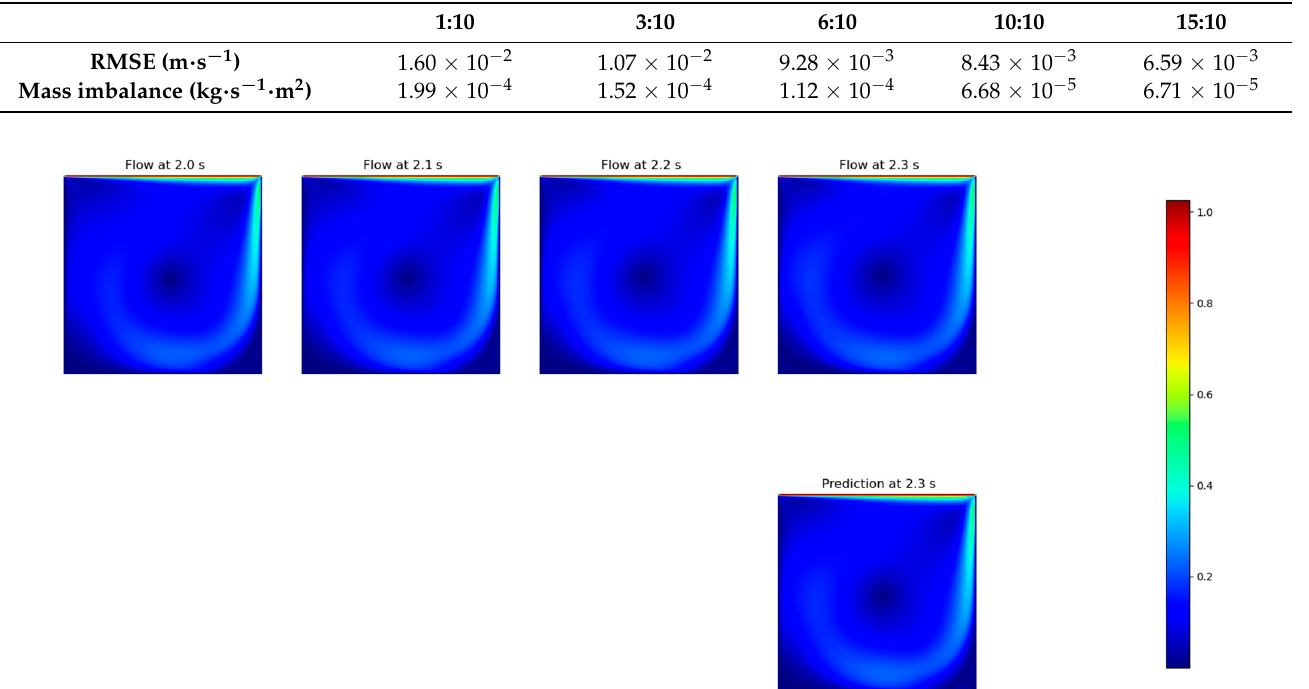
Figure 8. FNO prediction of the resulting speed for the 3 timesteps input. The ground truth plots are above, and the forecasted field is below.